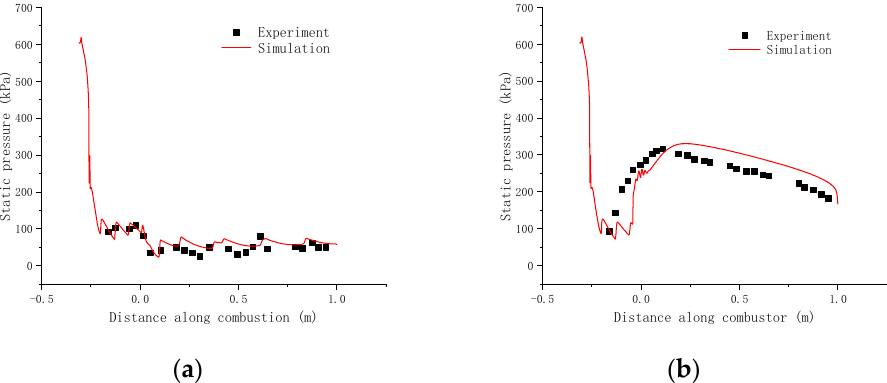
Figure 4. Comparison curves of wall pressure under the conditions of equivalence ratio of ( a ) 0 and ( b ) 0.71.